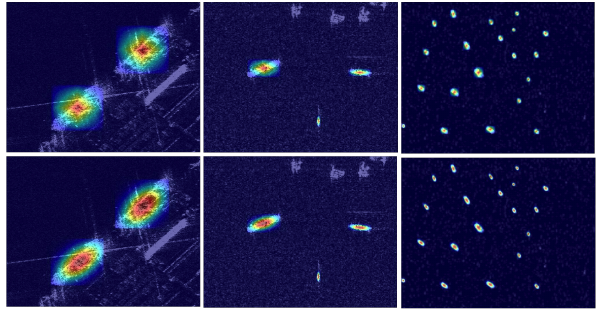
Figure 7. Visualization results of Center-ness and Gauss-ness.